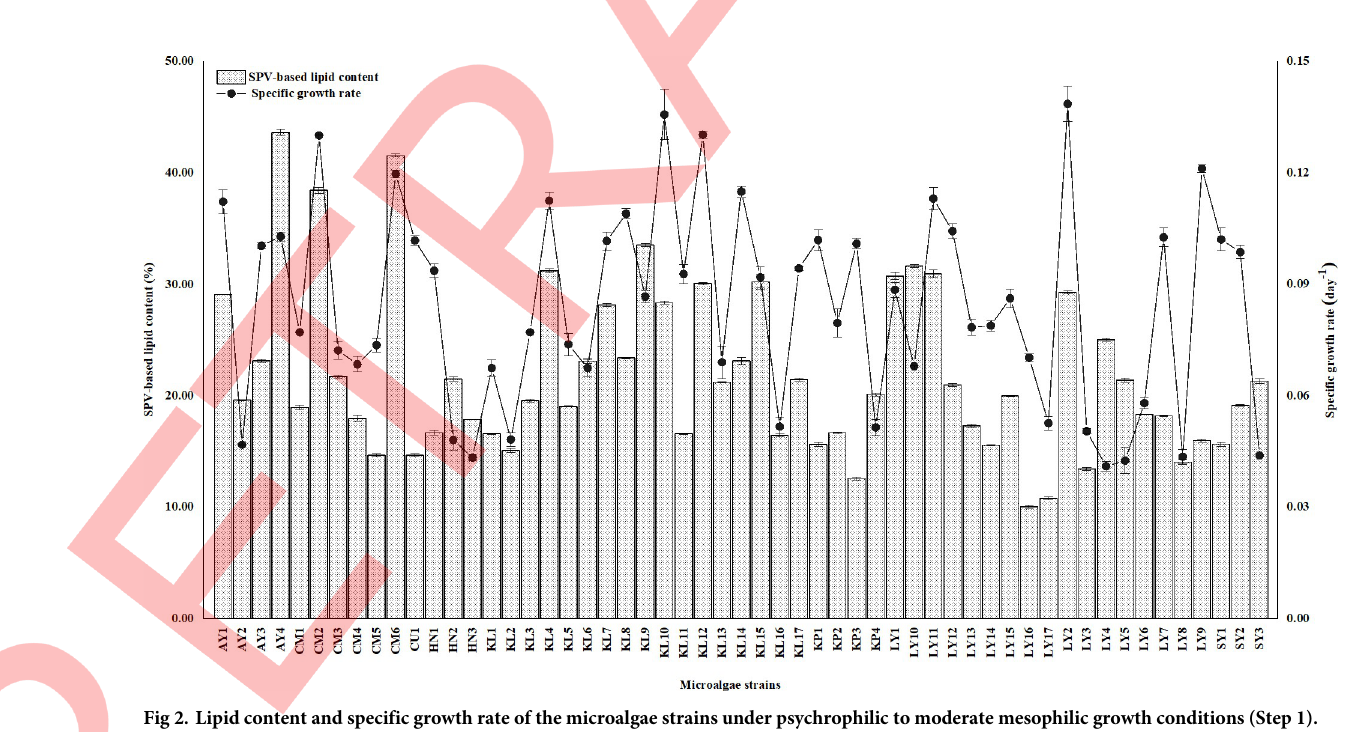
PLOS ONE | https://doi.org/10.1371/journal.pone.0267788 May 10,